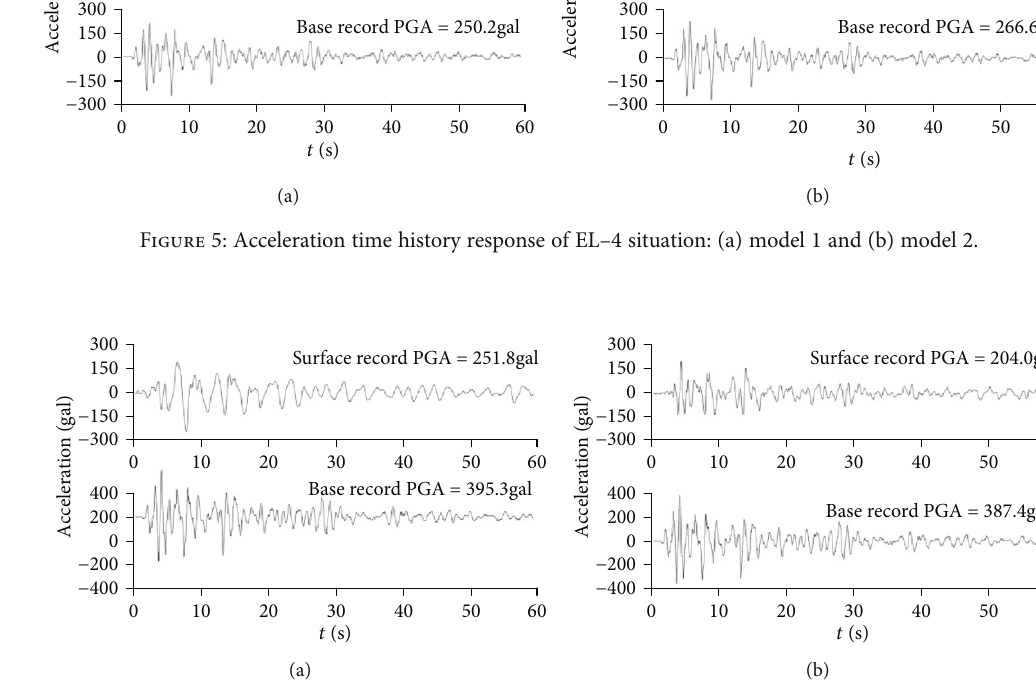
Figure 6: Acceleration time history response of EL – 5 situation: (a) model 1 and (b) model